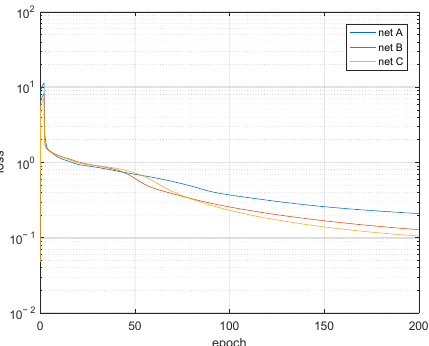
Figure 8. Training loss of diffraction loss prediction.